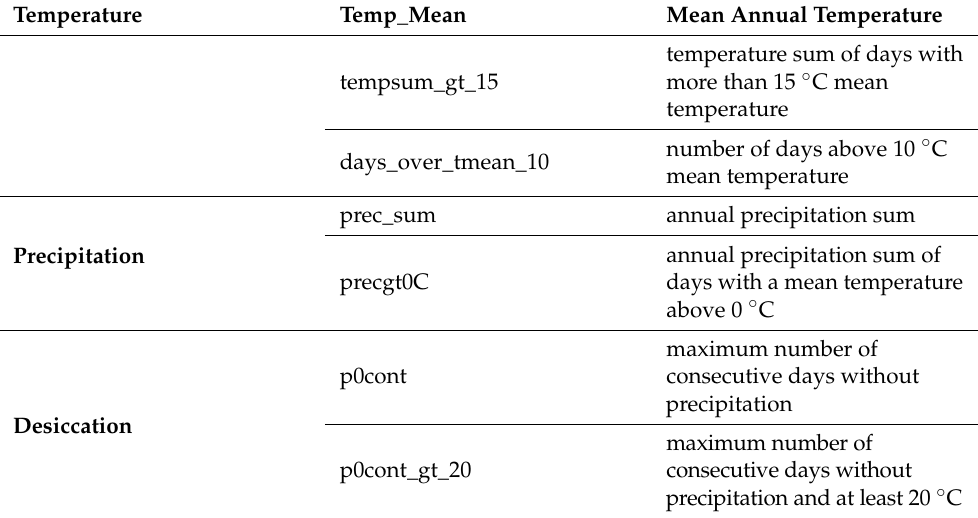
Table 1. List of climatic variables used in the